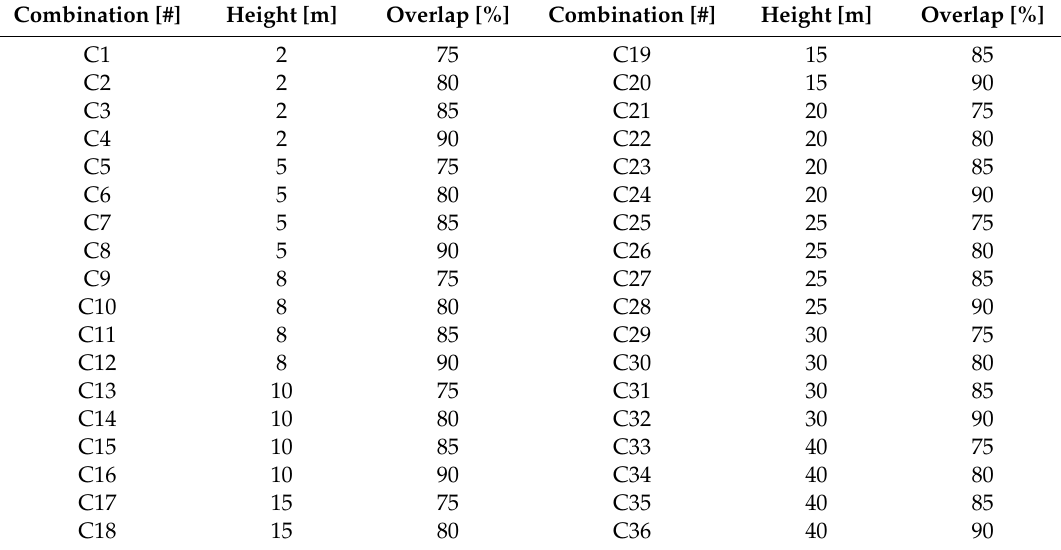
Table 3. Height and overlap of each combination, associated with Figures